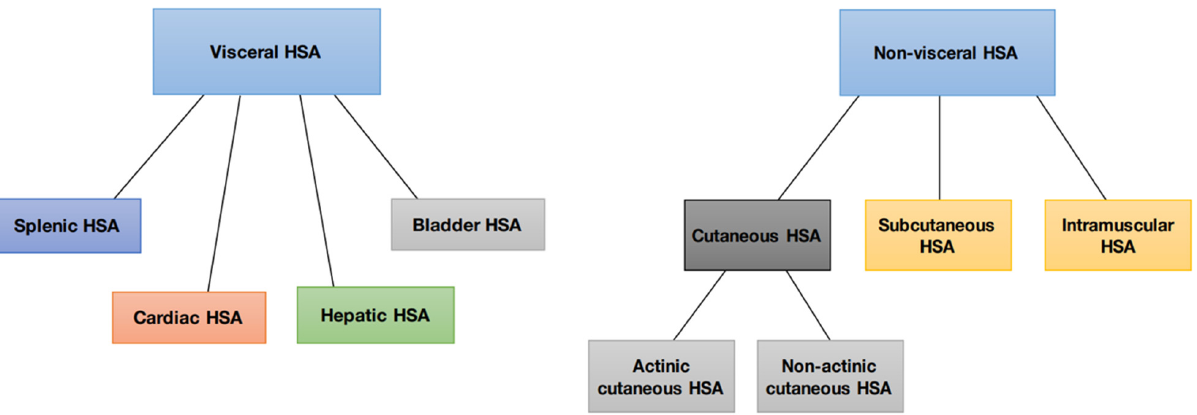
Figure 1. Schematic representation of the division of canine hemangiosarcoma into visceral and non-visceral.